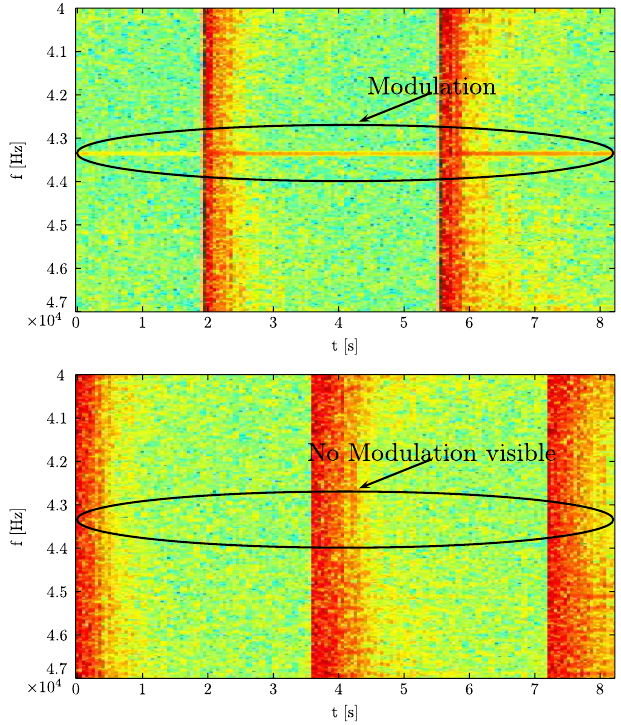
FIG. 4. Spectrum mode after phase demodulation in the un- coated (upper graph) and coated (lower graph) section. The red peaks correspond to the injection of a new batch. The data were taken with the nominal LHC 25 ns beam of four batches at SPS flat bottom.